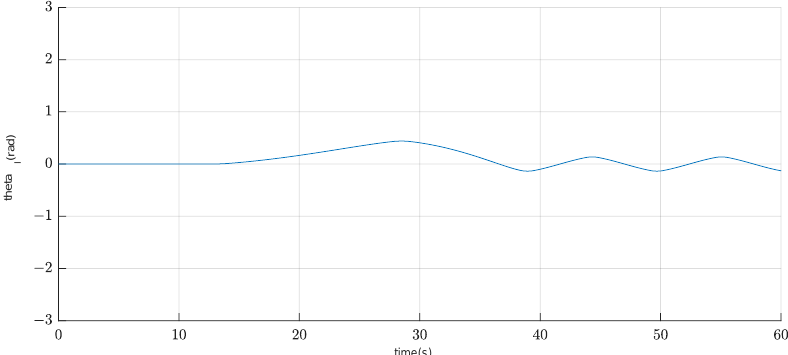
for the leader during the movement. 𝜃𝜃 𝑙𝑙